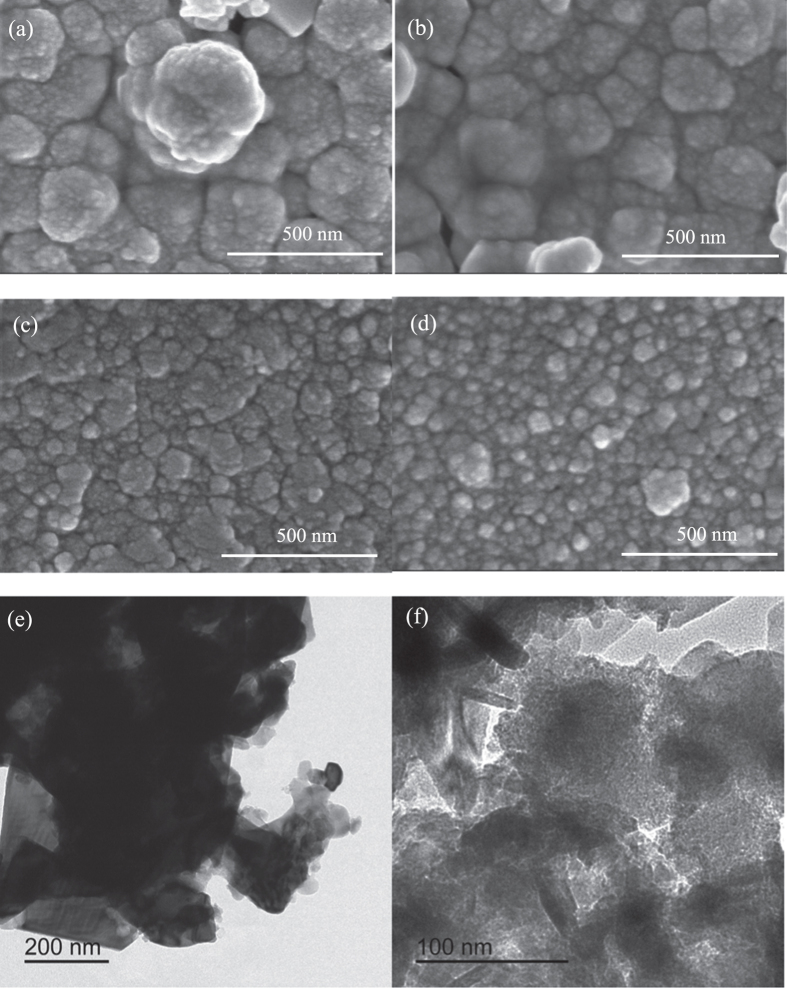
SEM micrographs of the (a) MoS2, (b) MoS2:Cu2+, (c) MoS2/rGO and (d) MoS2:Cu2+/rGO films deposited on glass substrate, and TEM micrograph of (e) MoS2 and (f) MoS2:Cu2+/rGO nanostructures